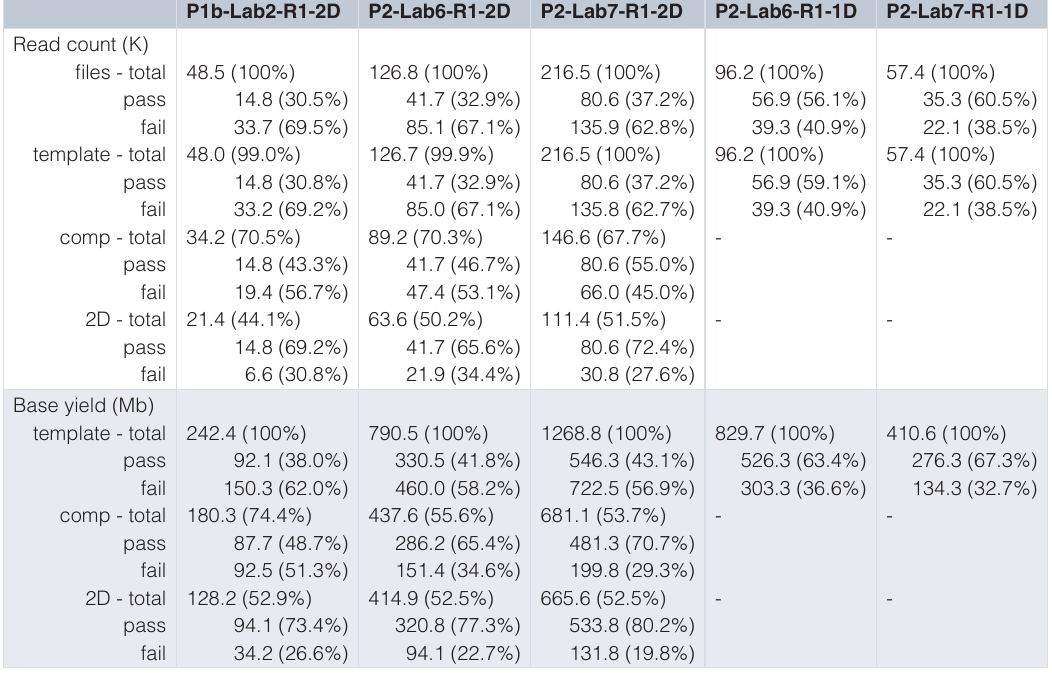
Table 2. Read counts and base yields. (“-”) indicates not applicable.